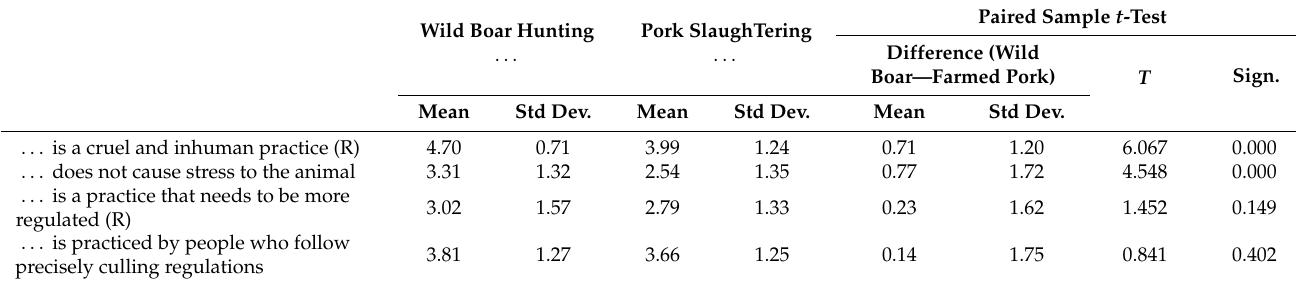
Table 4. Culling—Hunting vs. Slaughtering.